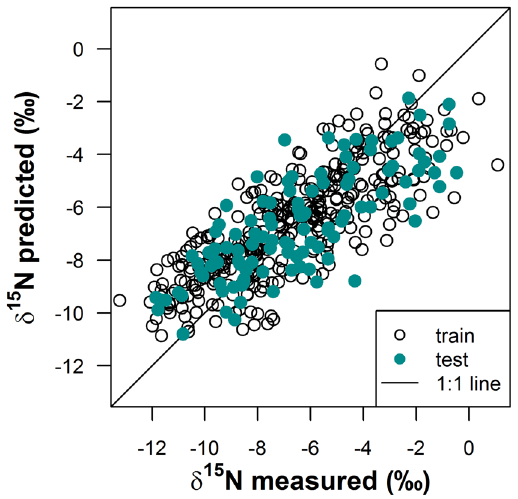
Figure 2. Measured foliar δ 15 N values of C. album versus δ 15 N values predicted by the additive mixed model for the training and the test set of the model which was closest to the median R 2 out of 100 model runs with random data splits. The 1:1-line is indicated.